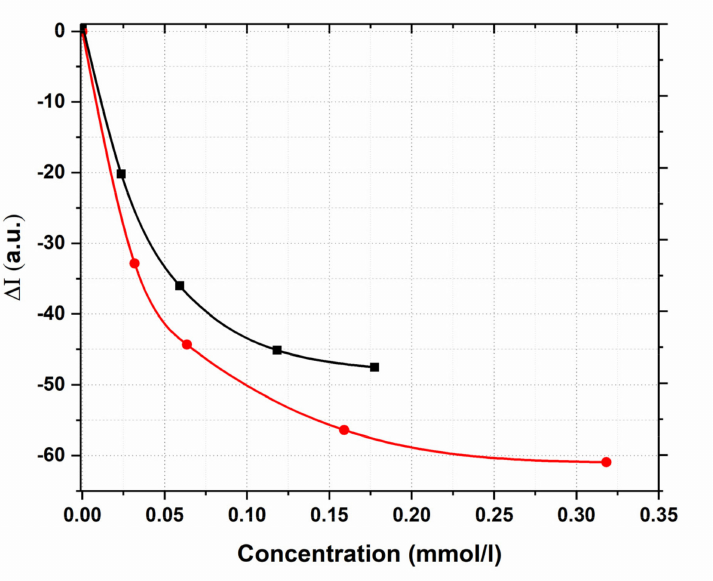
Figure 8. SOS quenching of the humic complex with increasing concentrations of dissolved mangiferin (black line) and favipiravir (red